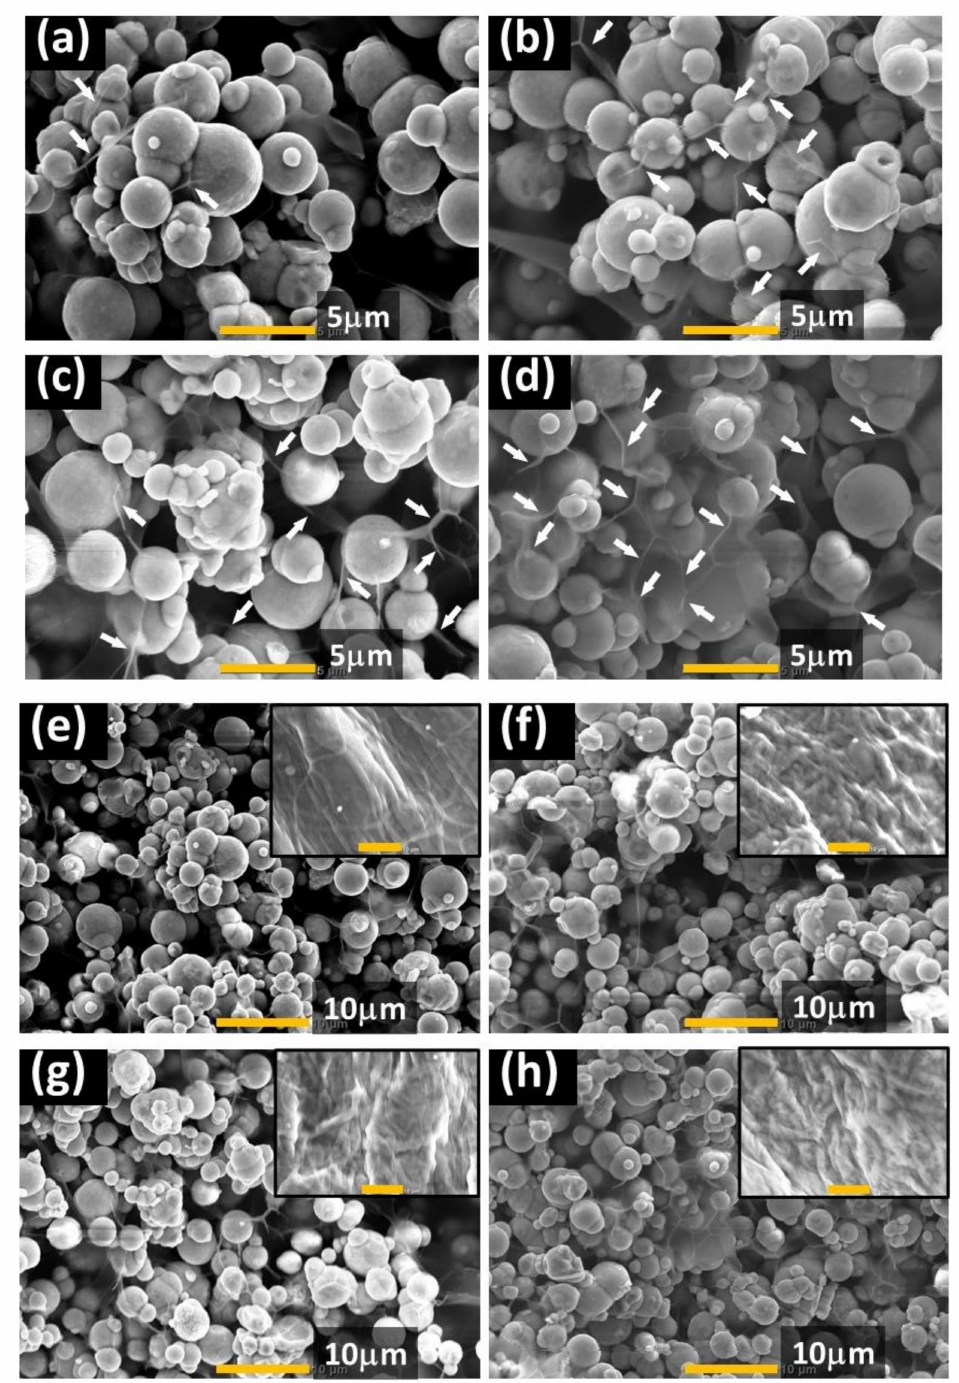
Figure 7. SEM photographs for 1 wt% carrageenan magnetic hydrogels taken at various conditions: ( a , e ) initial state before applying strain, ( b , f ) after applied large strain, ( c , g ) after applying a magnetic field of 500 mT, and ( d , h ) after applying large strain under a magnetic field of 500 mT. Inset: 1 wt% carrageenan hydrogels without magnetic particles. Magnification ( a – d ) × 5500 (scale bar = 5 µ m) and ( e – h ) × 2400 (scale bar = 10 µ m). Stretched fibers of carrageenan are indicated by arrows in ( a – d